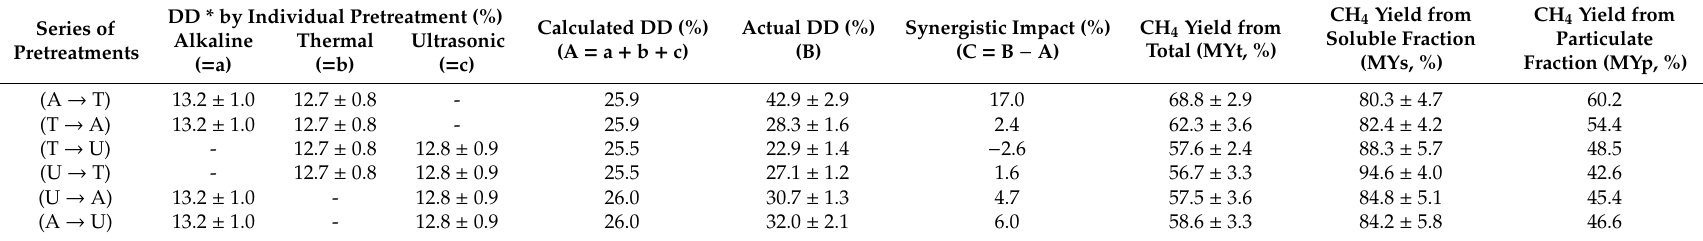
Table 1. E ff ect of di ff erent series of pretreatments on the solubilization of waste activated sludge, and CH 4 yield from di ff erent fractions of pretreated waste activated